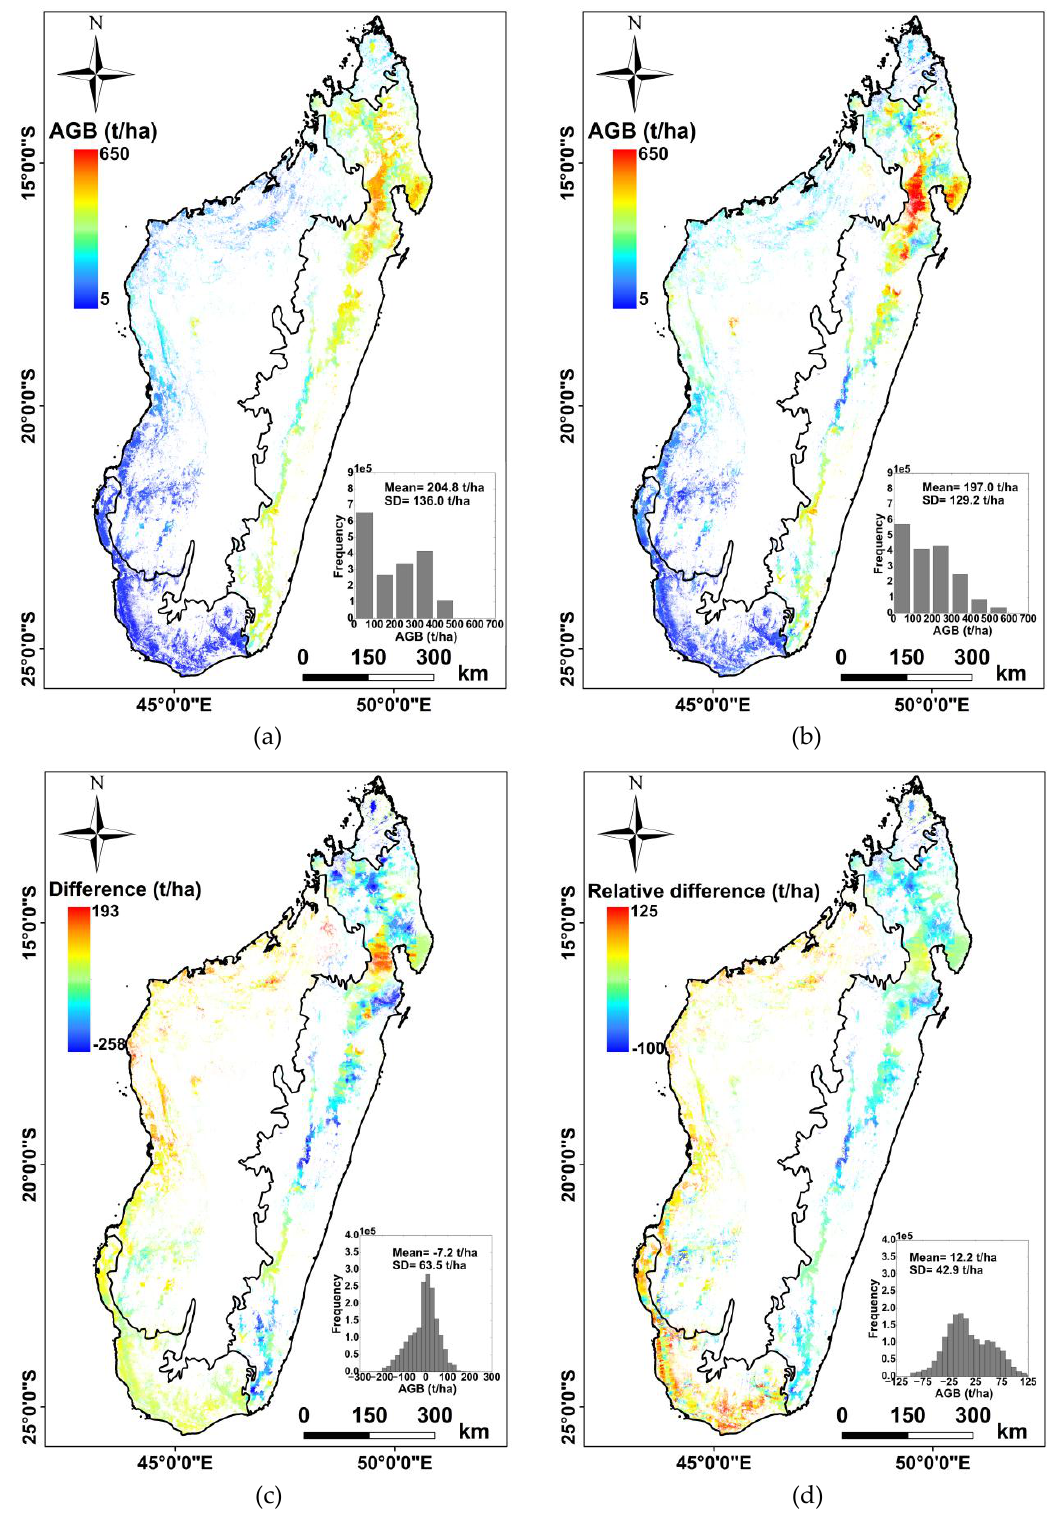
Figure 7. ( a ) Vieilledent’s AGB map [28] ( b ) the improved AGB map; ( c ) map of the absolute difference (the improved AGB map—Vieilledent’s AGB map); ( d ) map of the relative difference. SD: Standard Deviation.